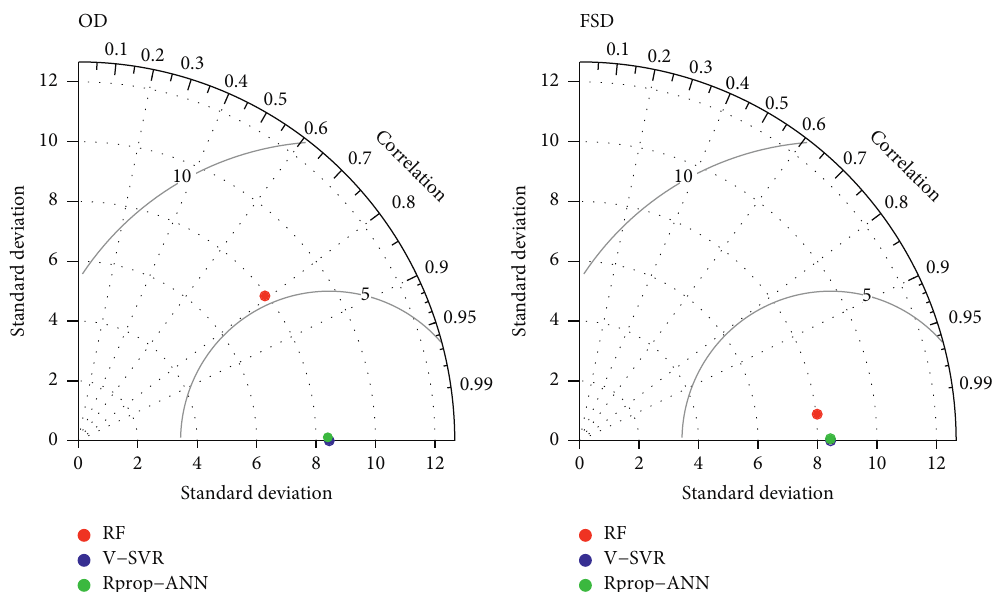
Figure 5: Taylor diagram comparing predicted DGSR from RF, V-SVR, and Rprop-ANN on OD and FSD.